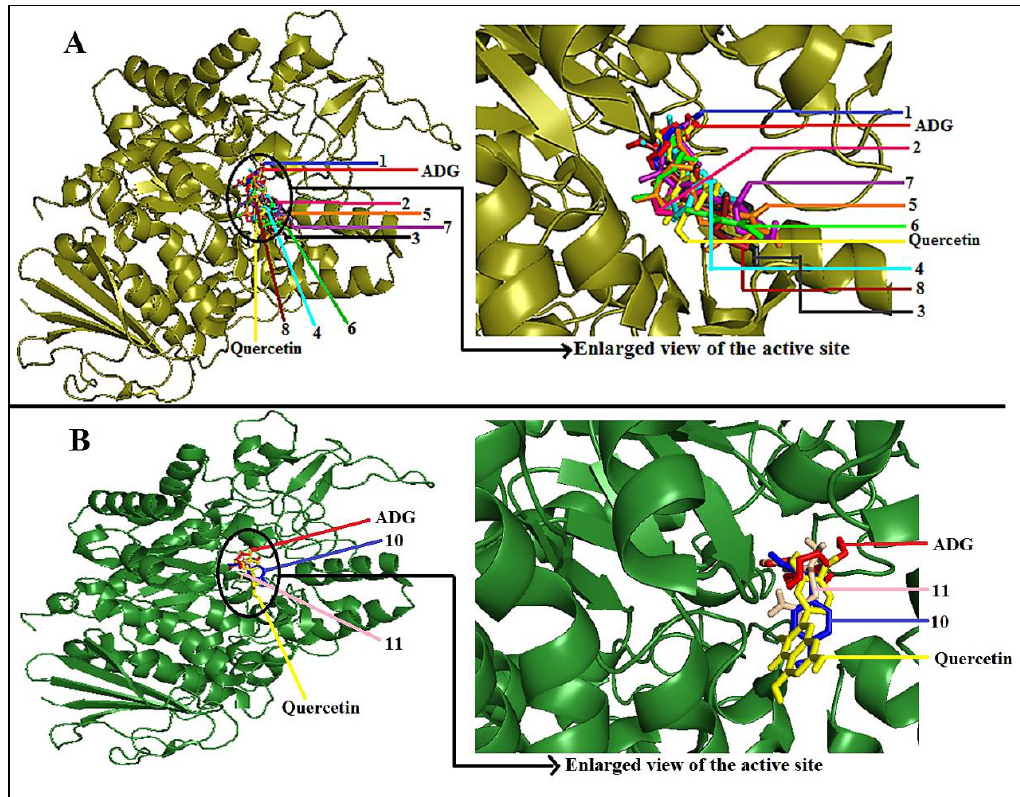
Figure 9. ( A ) 3D superimposed diagram of the bioactive compounds ( 1 – 8 ) identified by GC-MS analysis, ADG, and quercetin in enzyme (3A4A). ( B ) 3D superimposed diagram of the bioactive compounds ( 10 and 11 ) identified by NMR analysis, ADG, and quercetin in the enzyme (3A4A). Figure ( A , B ) indicate the simulated binding site of the putative bioactive compounds on the α -glucosidase enzyme (3A4A).